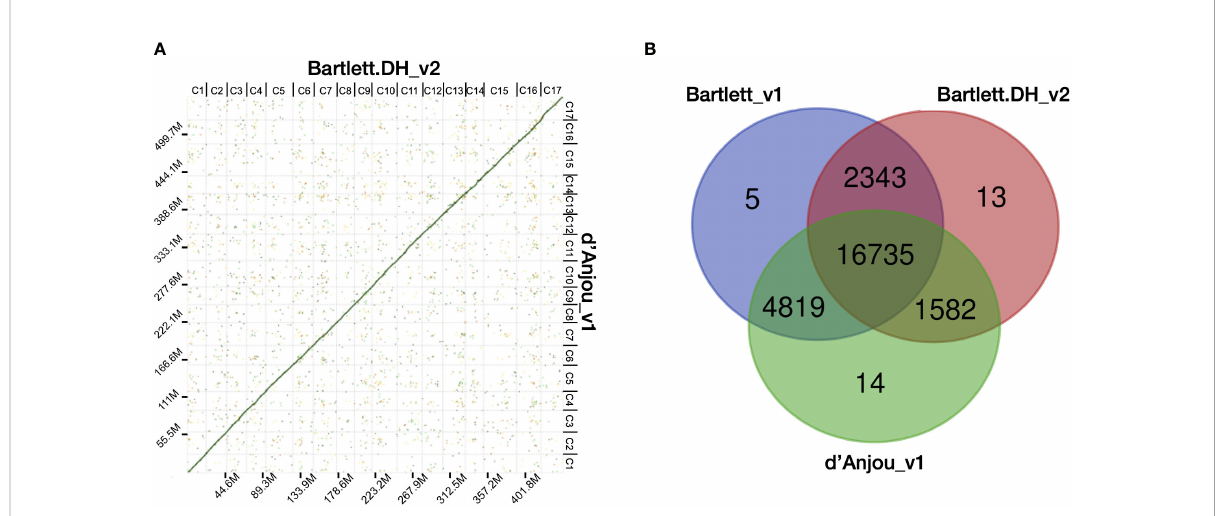
FIGURE 1 Characterization of the d ’ Anjou genome and protein orthology among European pears. (A) Dot plot of genome alignment of Bartlett.DH_v2 (x axis) and d ’ Anjou (y axis). (B) Overlap and distinctiveness of gene annotations among three Pyrus communis genotypes, Bartlett_v1, Bartlett.DH_v2, and d ’